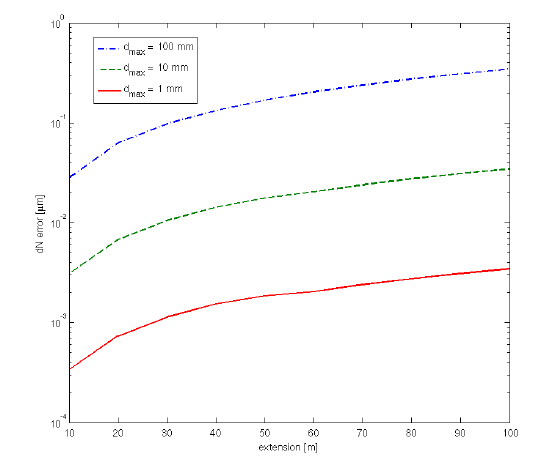
Figure 9. Theeffectofcircularsubsidenceonthegravityfieldasfunc- tion of the radius of the subsiding area.